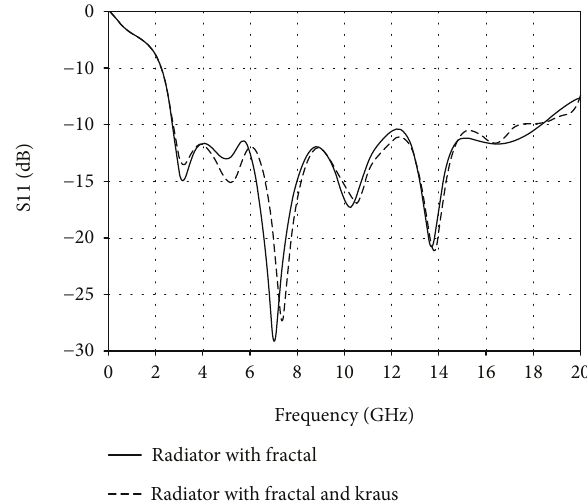
Figure 4: Simulated S11 parameter by employing the fractal and fractal-Kraus